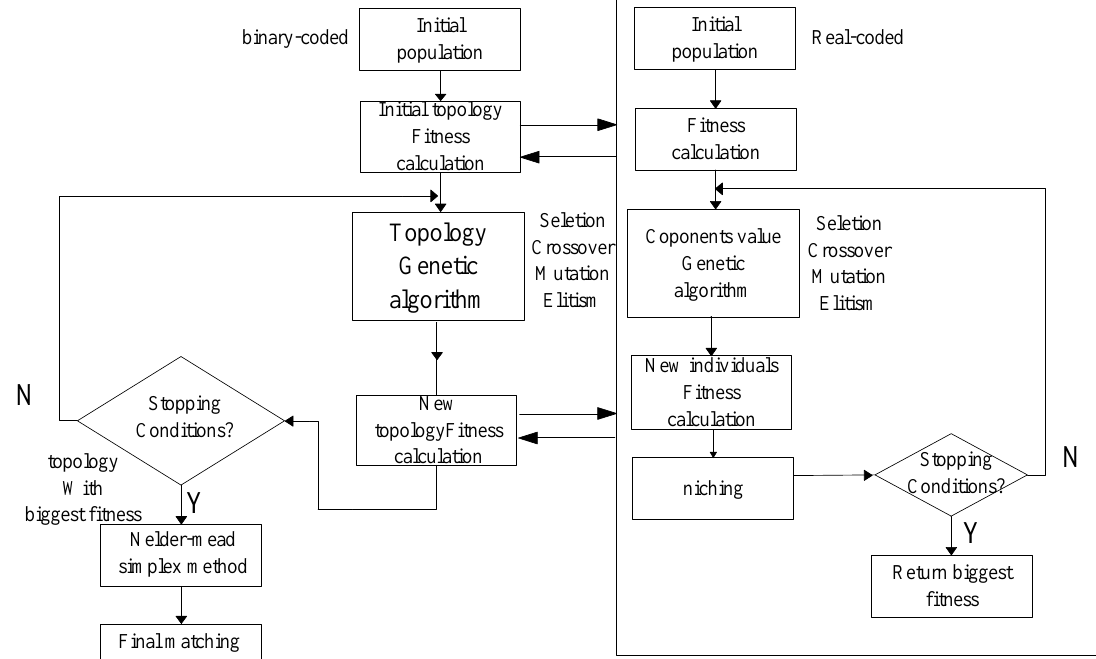
Figure 2. Overview of the new method based on